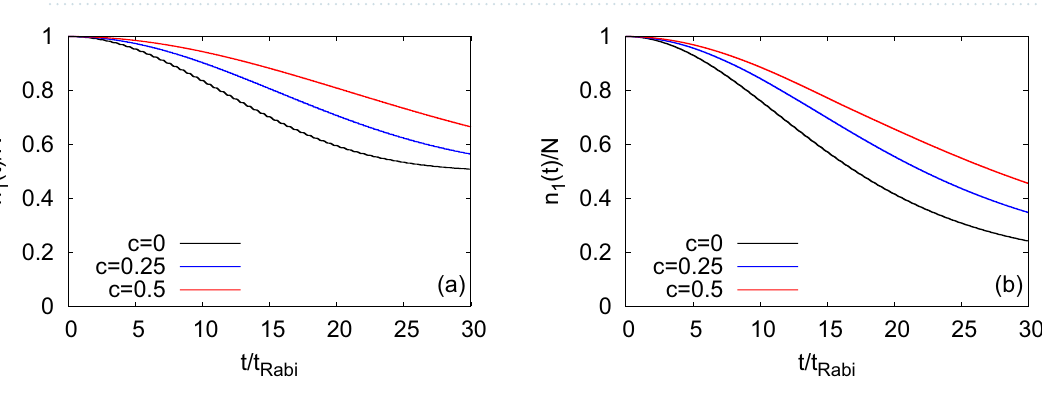
n t ) 1 ( Figure 4. Time-dependent occupation per particle of the first natural orbital, N , in a longitudinally- 10 bosons and interaction parameter � 0.01 π . Panels ( a ) and asymmetric 2D double-well potential for N = = 0 , 0.25, and 0.5. The data have been ( b ) are for (cid:31) G and (cid:31) Y , respectively. The asymmetry parameters are c = 6 time-dependent orbitals for (cid:31) G and M 10 time-dependent orbitals for (cid:31) Y . We show obtained with M = = here dimensionless quantities. Color codes are explained in each